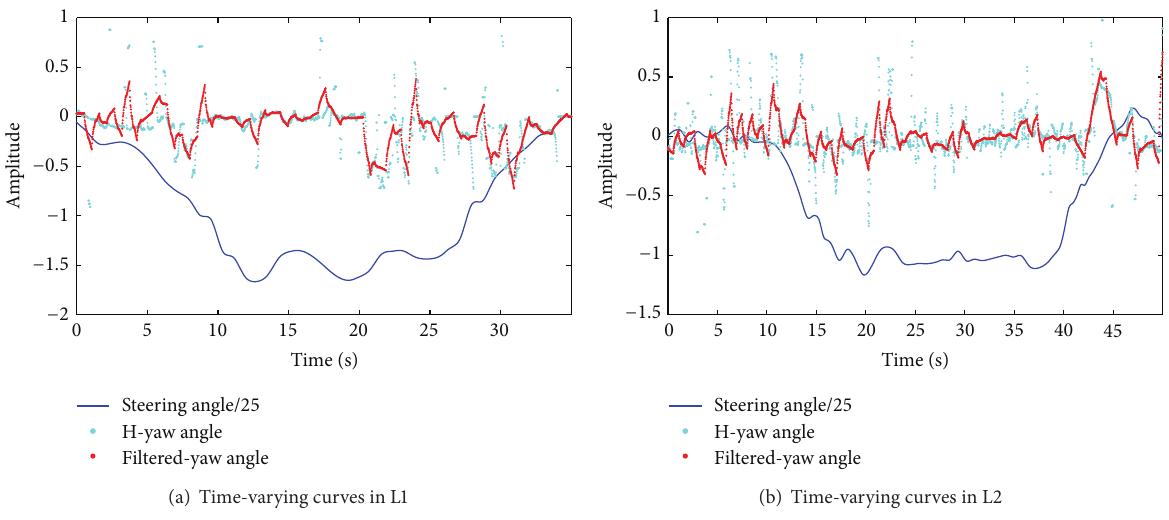
Figure 4: Steering angle and driver’s gaze direction when driving around left-hand curves.